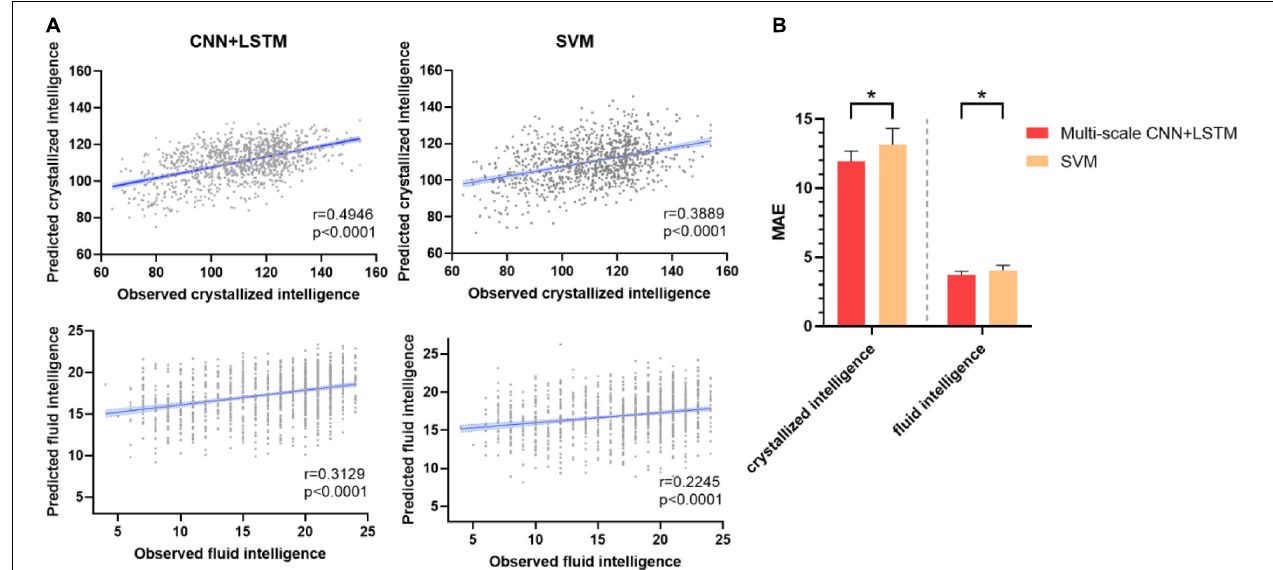
FIGURE 3 | Prediction performance of fluid intelligence and crystallized intelligence. (A) The correlations between predicted and observed intelligence scores for the CNN + LSTM and support vector machine (SVM) models. Note that the CNN + LSTM model exhibits the highest correlation scores for both tasks. Each subject is represented by one dot, and 95% confidence interval for the best-fit line is represented by the gray area which is used to assess the predictive power of the model. (B) Comparison between mean MAE across 10 testing folds for the CNN + LSTM and the SVM model. Lower is better. Bars refer to the mean accuracy of all testing folds, and error bars refer to their standard error. Note that the CNN + LSTM model is statistically better than the SVM model (* p <